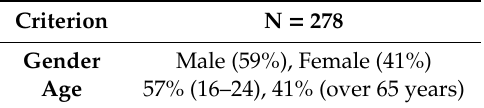
Table 2. Demographic of participants by age